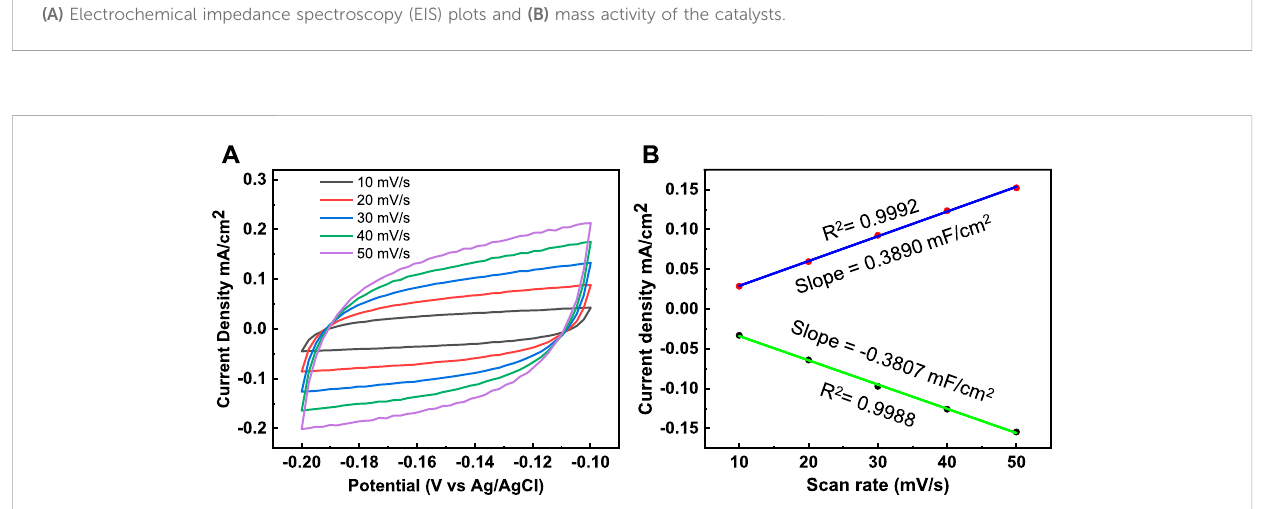
FIGURE 9 (A) Cyclic voltammetry curves and (B) the corresponding plots of J a and J c against the scan rate for the determination of double-layer capacitance